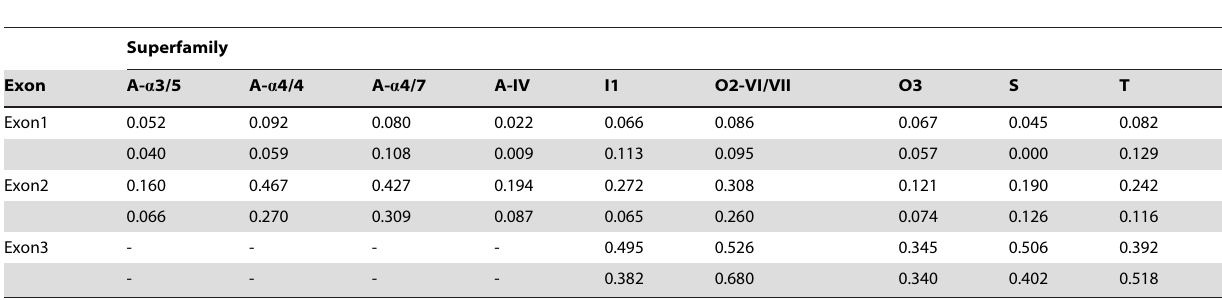
Table 5. Dn (top) and Ds (bottom) values of each exon sequence within six conotoxin superfamilies.